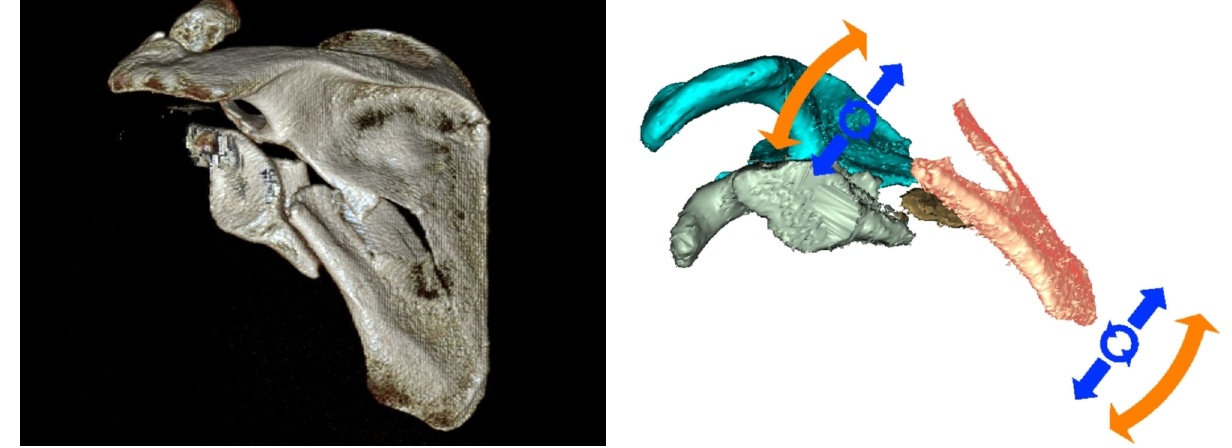
Figure 3: Manual reduction of the